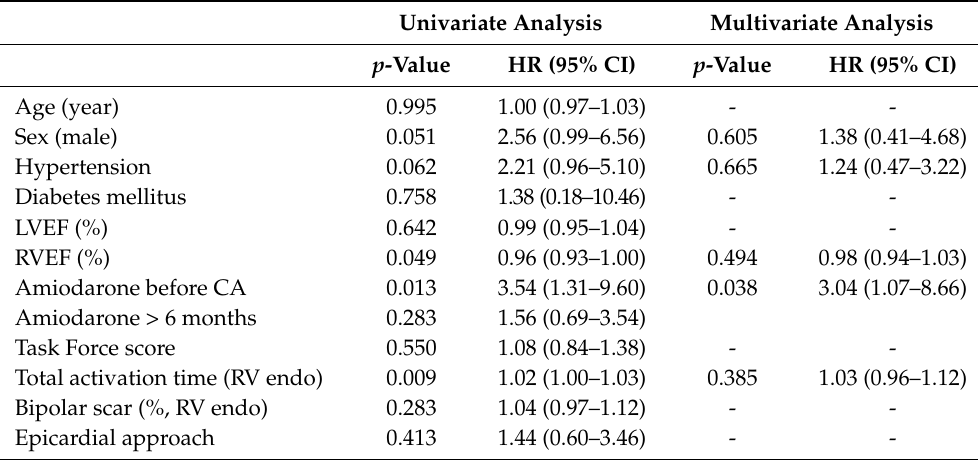
Table 3. Univariate and multivariate analyses of VT/VF recurrence after catheter ablation.